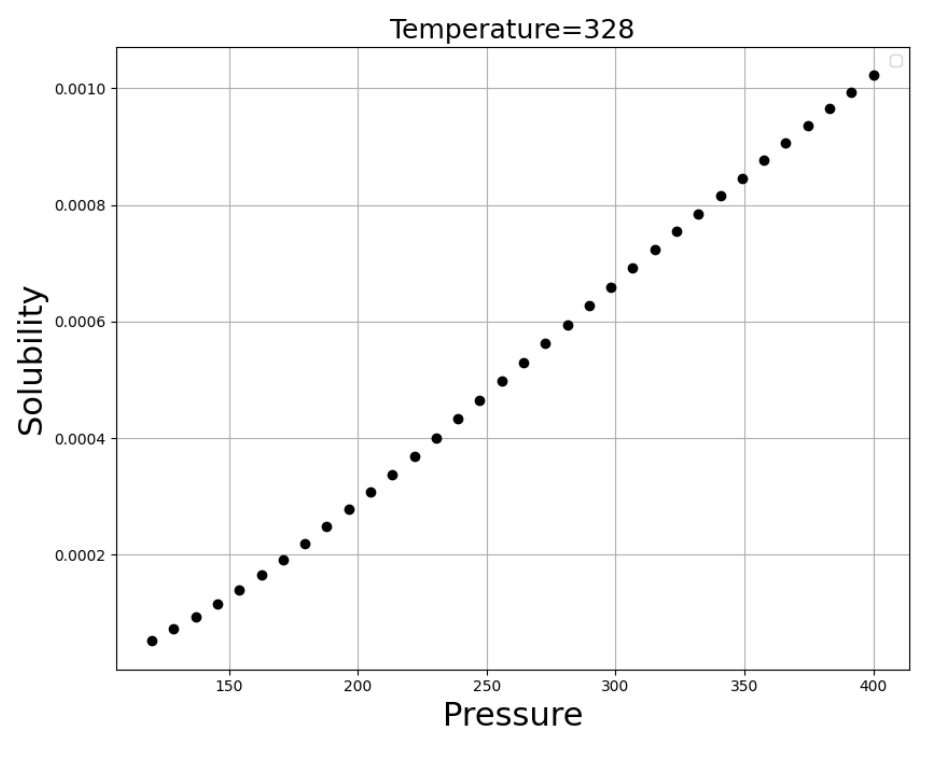
Figure 6. Trends for Temperature (K).